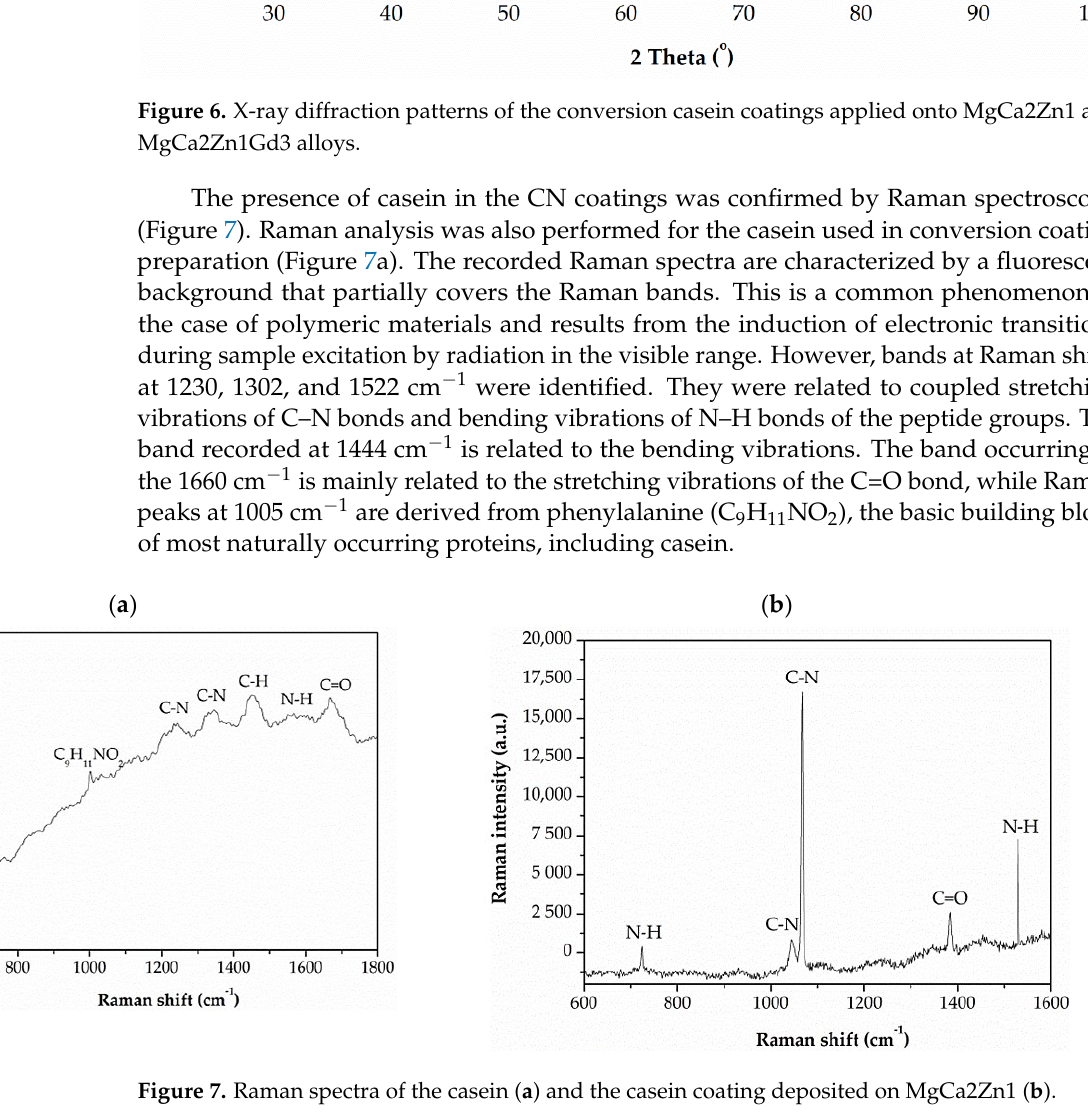
Figure 6. X-ray diffraction patterns of the conversion casein coatings applied onto MgCa2Zn1 and MgCa2Zn1Gd3 alloys.